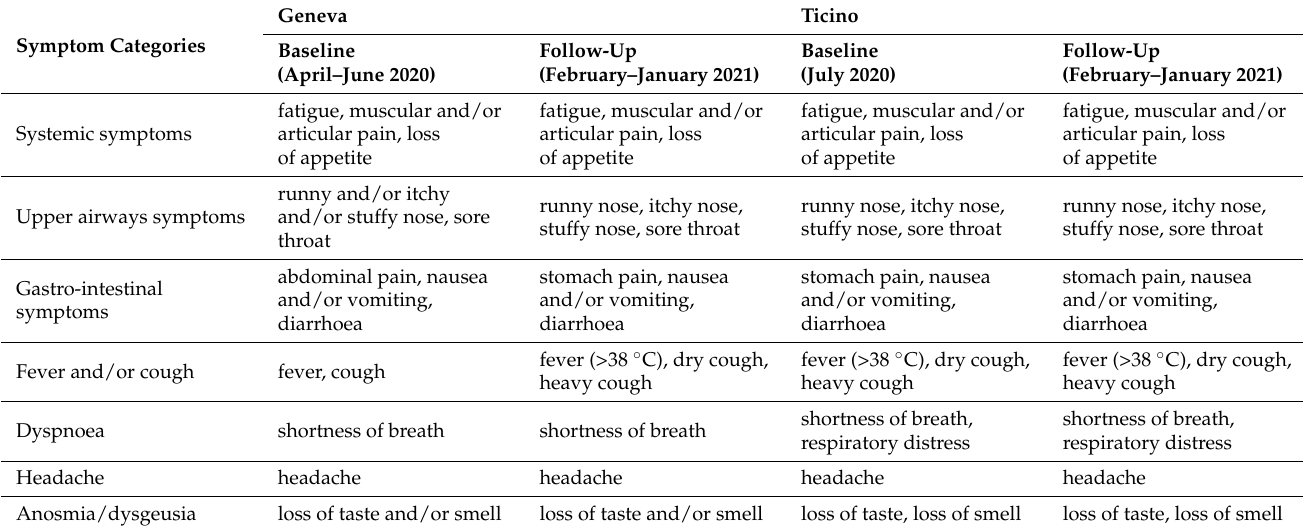
Table A2. List of available self-reported COVID-19-compatible symptoms across studies and assessments.